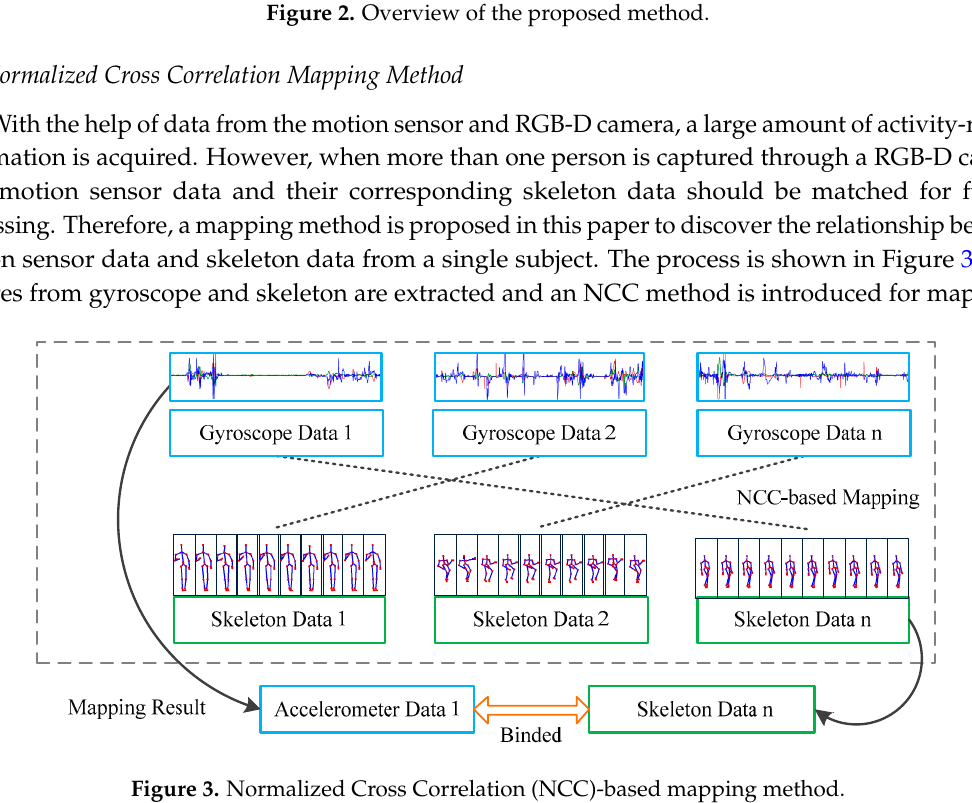
Figure 3. Normalized Cross Correlation (NCC)-based mapping method.